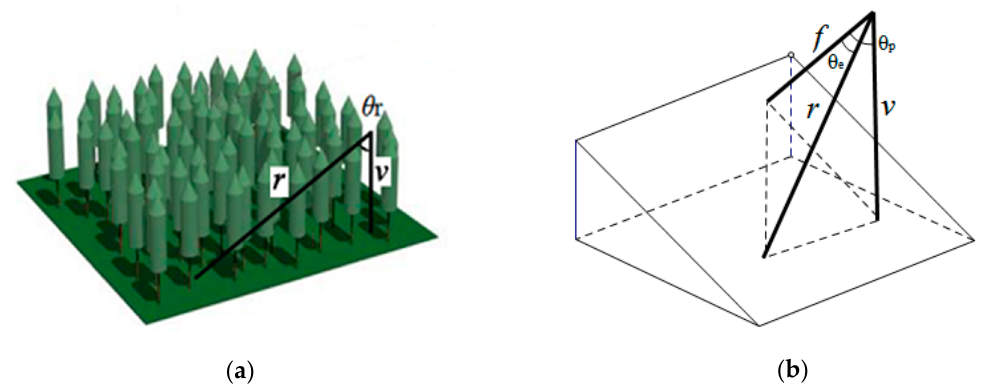
Figure 5. The effect of slope: ( a ) Effective canopy depth in the horizontal area; ( b ) Effective canopy depth in the slope area. r : effective canopy depth; v : height of the plant; f : normal of the slope.